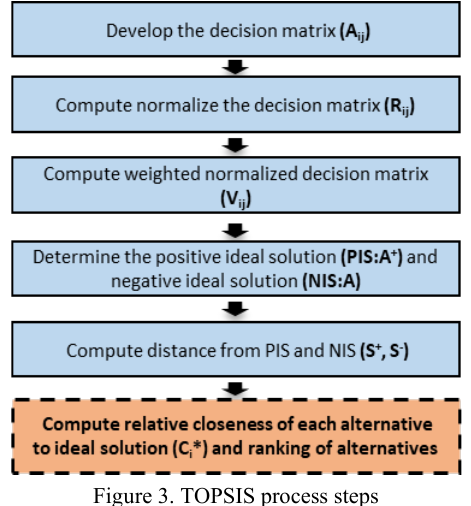
Figure 3. TOPSIS process